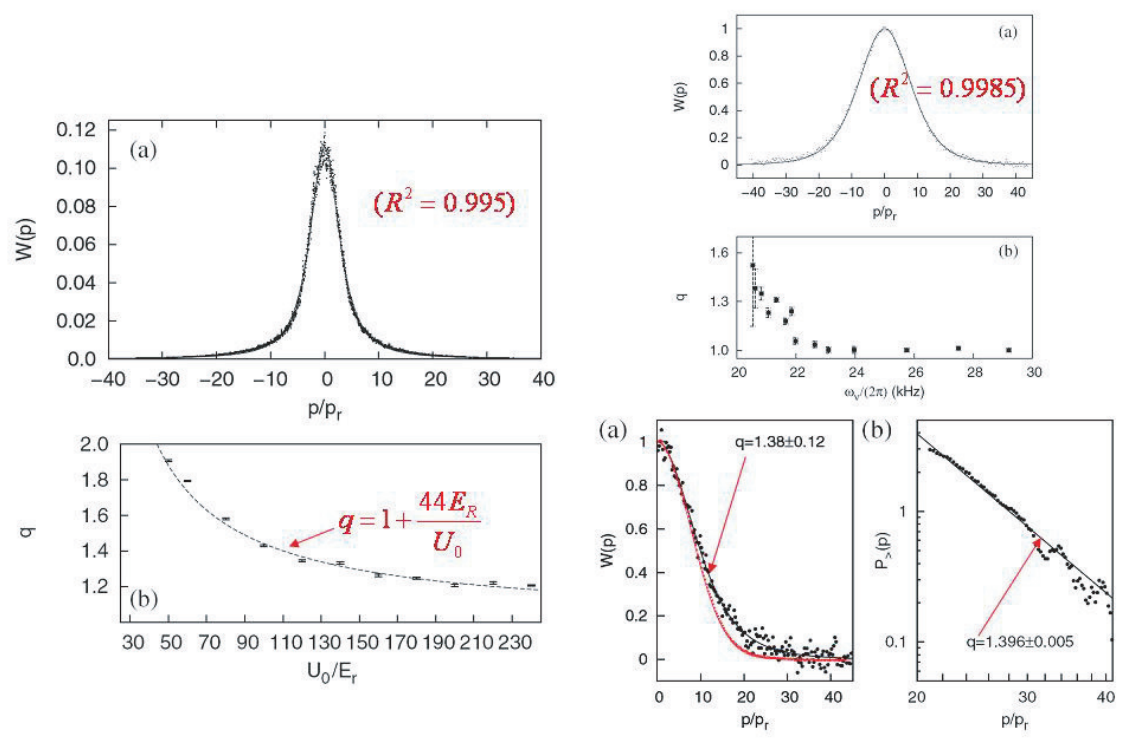
Figure 15. Quantum Monte Carlo verification ( left panels ) [( a ) Analytic and numerical distribu- tions; ( b ) Analytical and numerical functions q ( U 0 / E r ) ], and laboratory verification with C s atoms ( right panels ) [( Top a ) Analytical and experimental distributions; ( Bottom b ) Experimental frequency dependence of q ; ( Left a ) Linear-linear representation of the experimental distribution of momenta, the black curve corresponding to the present q -Gaussian, the red curve corresponding to a Maxwellian distribution; ( Right b ) The same in log-log representation.] of the 2003 Lutz prediction. From